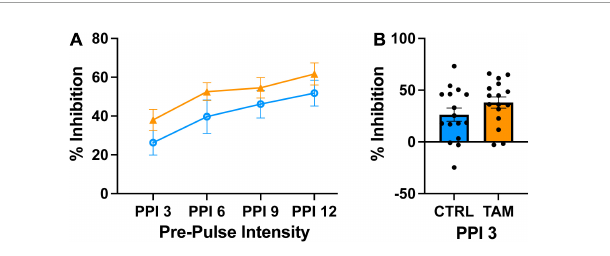
FIGURE5 Tamoxifen treatment does not alter pre-pulse inhibition (PPI). Blue lines and bars show results from control mice (CTRL); orange lines and bars show tamoxifen-treated mice (TAM). (A) Percent inhibition of startle response to a loud tone following a pre-pulse of 3, 6, 9, or 12 decibels (dB) above background noise (PP3–PP12) compared to startle with no pre-pulse. (B) Percent inhibition of startle response to a short tone following the pre-pulse 3 decibels above background noise compared to startle with no pre-pulse 2 weeks post-treatment. N = 16 mice per group; mean ± standard error.